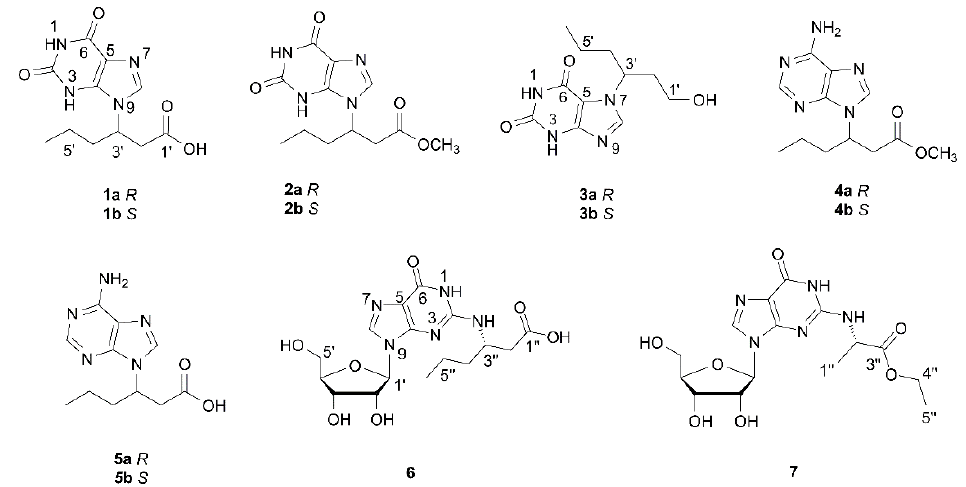
Figure 1. The structures of compounds 1 – 7 from Cyclopelta parva .